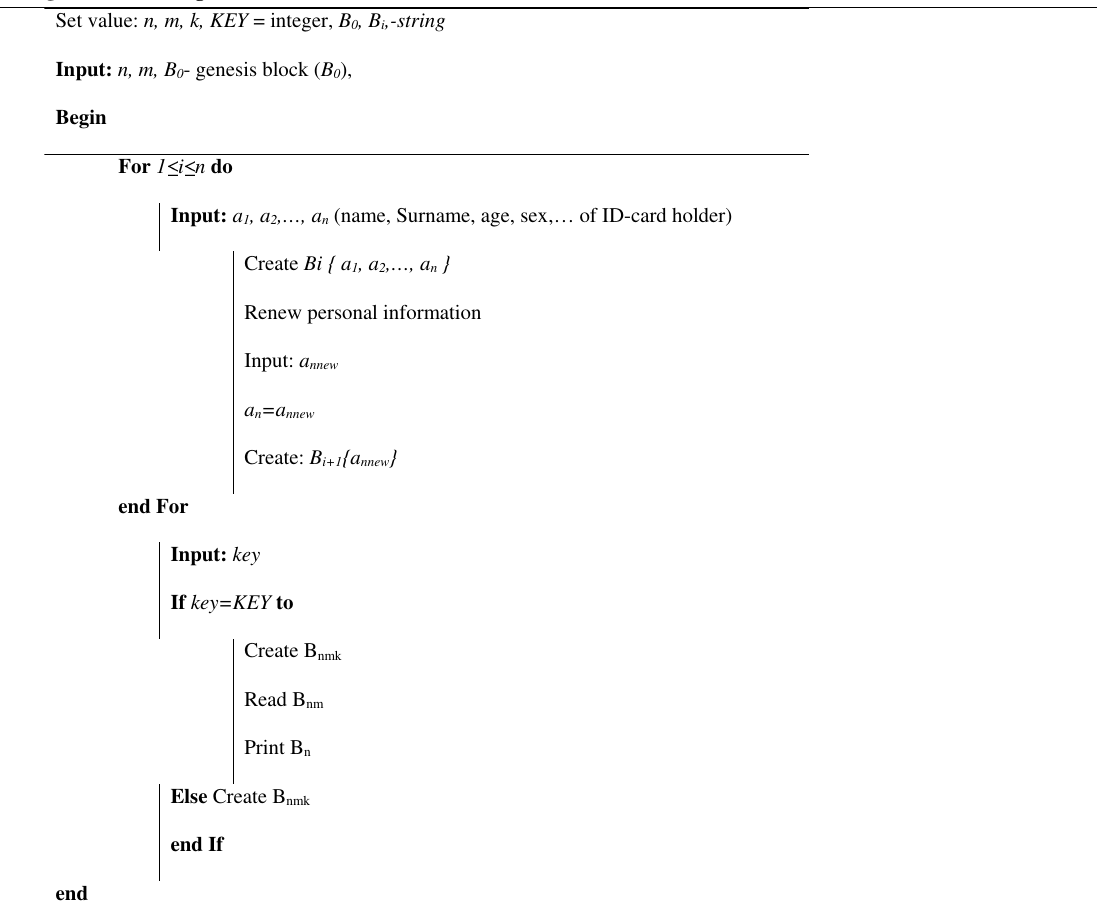
Algorithm 1: Algorithm of block formation in a